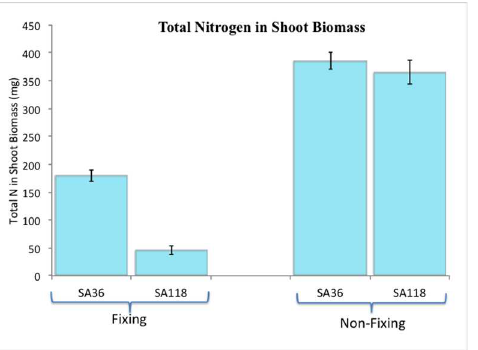
Fig 3. Differencesin total nitrogen in shoot biomass (per plant) between SA36 and SA118grown under nitrogen fixing and non-fixing